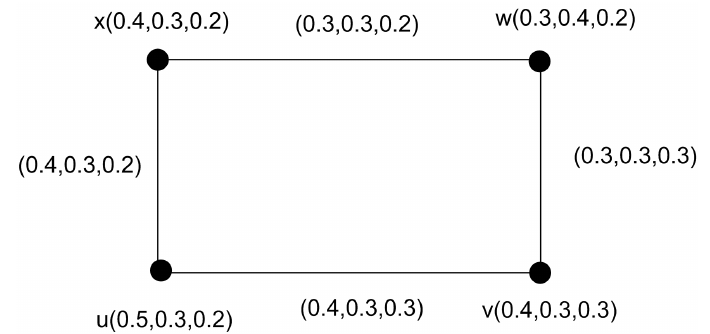
Figure 2. A strong picture fuzzy